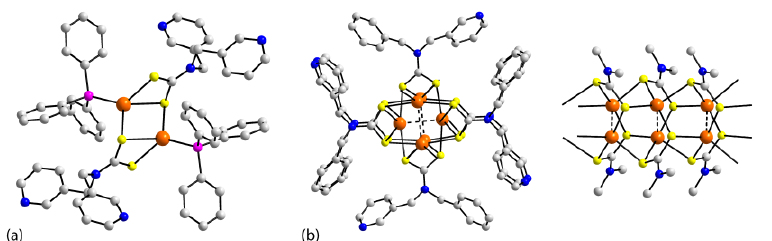
Figure 4. ( a ) Molecular structure for [(Ph 3 P)Ag(L 11 )] 2 ( 17 ) and ( b ) two views of the 1-D supramolecular chain in [Ag(L 1 )] n ( 18 ); in the right-hand image, all but the α-carbon atoms of the dithiocarbamate residues were removed. The dashed lines indicate M … M interactions, in this case M = Ag with the separation being 2.89 Å .